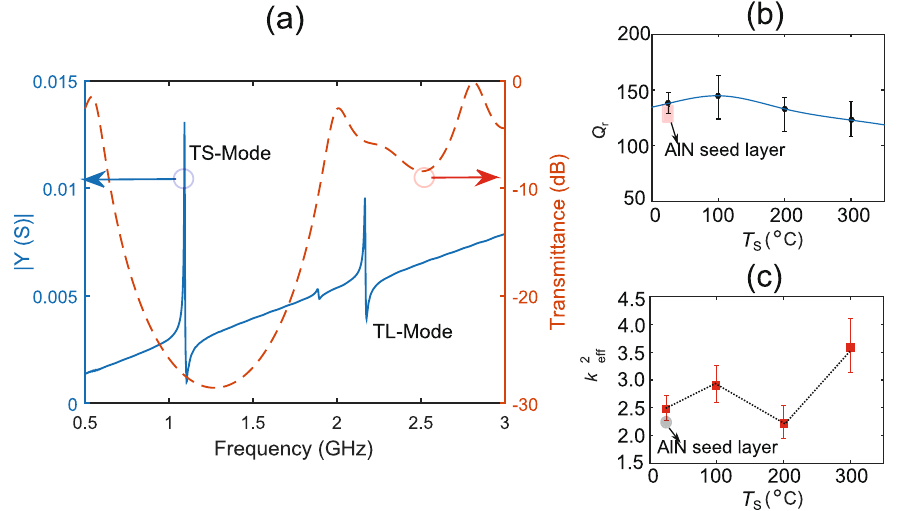
Figure 5. ( a ) Electrical admittance spectrum of a typical device showing a thickness shear mode resonance at 1.1 GHz and a thickness longitudinal mode resonance at 2.2 GHz. Dashed red line shows the modelled shear mode transmittance spectrum of the fabricated acoustic reflector. ( b ) Displays the average shear mode Q r of devices measured at each Al deposition temperature; T S ; the highest Q r is achieved at 100 °C. ( c ) Shows the k eff2 of devices, which follow a similar trend as Q r except at 300 °C where a mean shear mode k eff2 of 3.6% is achieved. Shaded areas in ( b , c ) show the performance of devices from our previous work using AlN seed layer to grow inclined c -axis ZnO 16